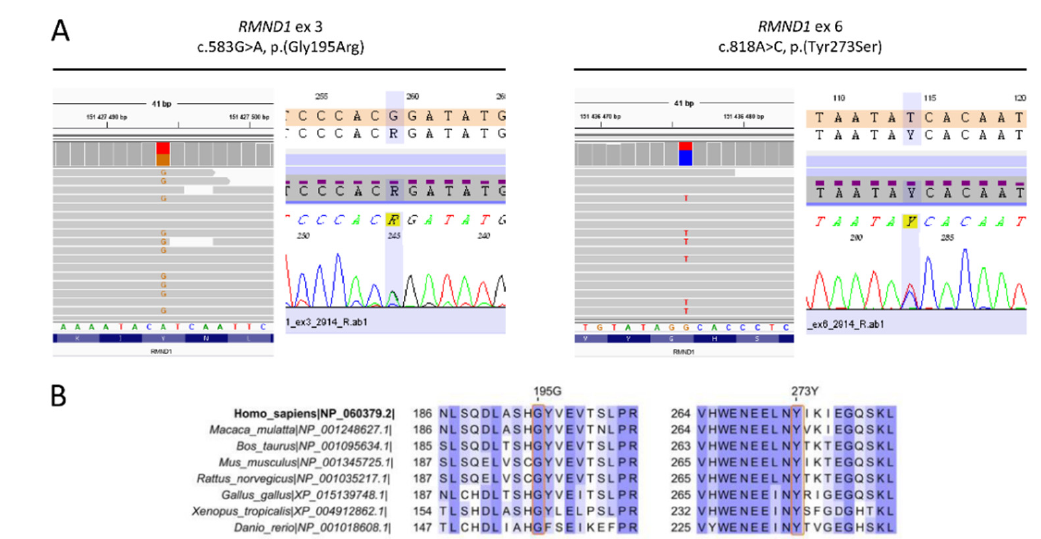
Figure 2. Genetic data of the investigated family. ( A ) Results of next-generation sequencing (NGS) and Sanger sequencing showing c.583G>A transition (p.Gly195Arg) and c.818A>C transversion (p.Tyr273Ser) in the RMND1 gene. ( B ) Multiple protein sequence alignment of selected RMND1 regions among different species.